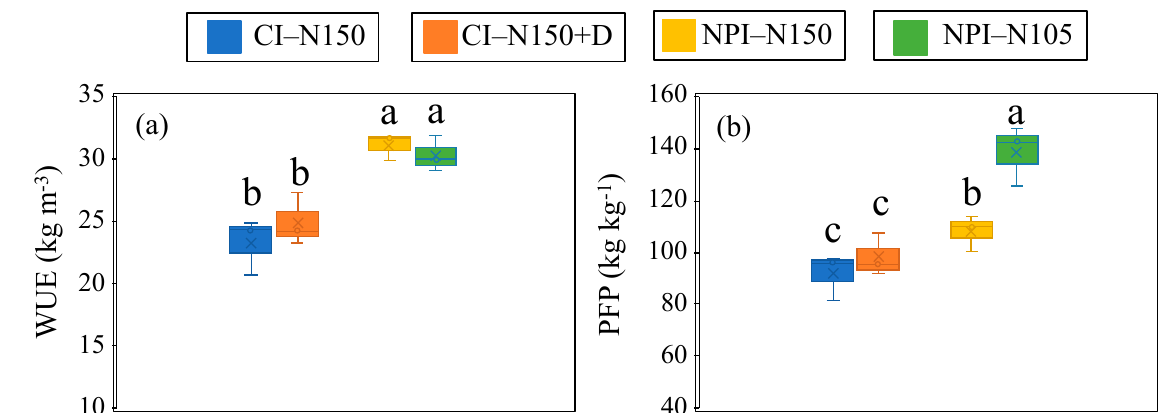
Figure 2. WUE and PFP under different irrigation and N treatments. ( a ) Water use efficiency (WUE); ( b ) Partial factor productivity (PFP) of the applied N. CI is conventional irrigation, and NPI is negative pressure irrigation. N150: 150 kg N ha − 1 , N105: 105 kg N ha − 1 ; D is DCD addition. All of the data are the means of three replicates ± SE, and different letters indicate significant differences between the treatments ( p < 0.05) by Duncan’s tests.